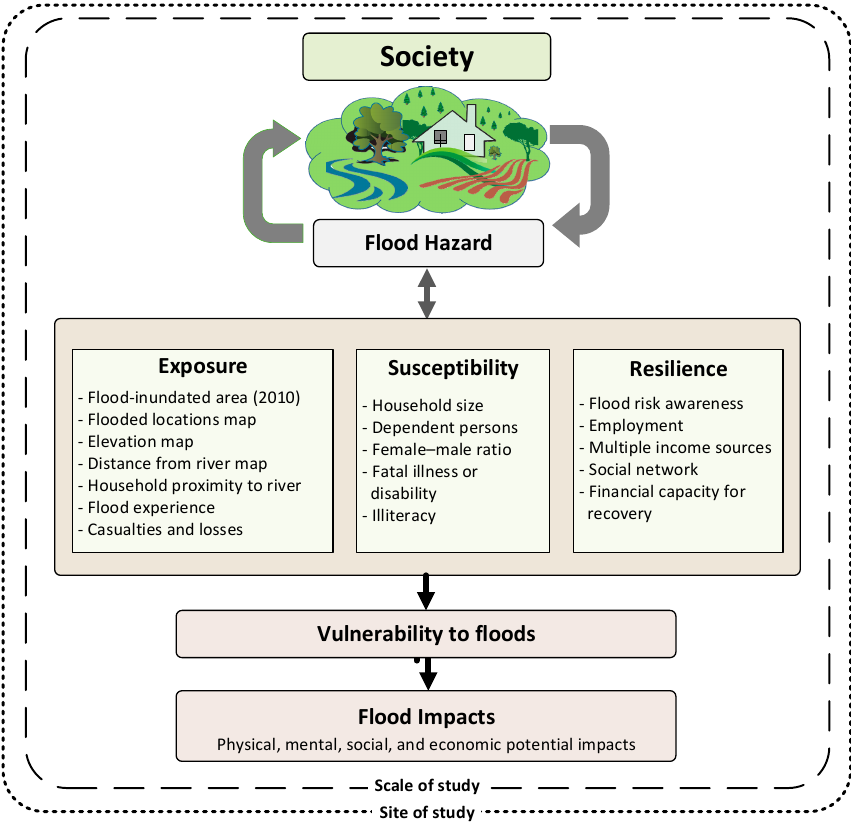
Figure 3. Conceptual framework for social vulnerability to flood hazards (own figure, based on the conceptual model by [55]).